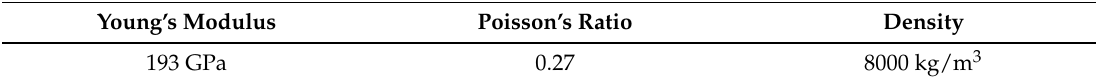
Table 2. Material properties (316 stainless